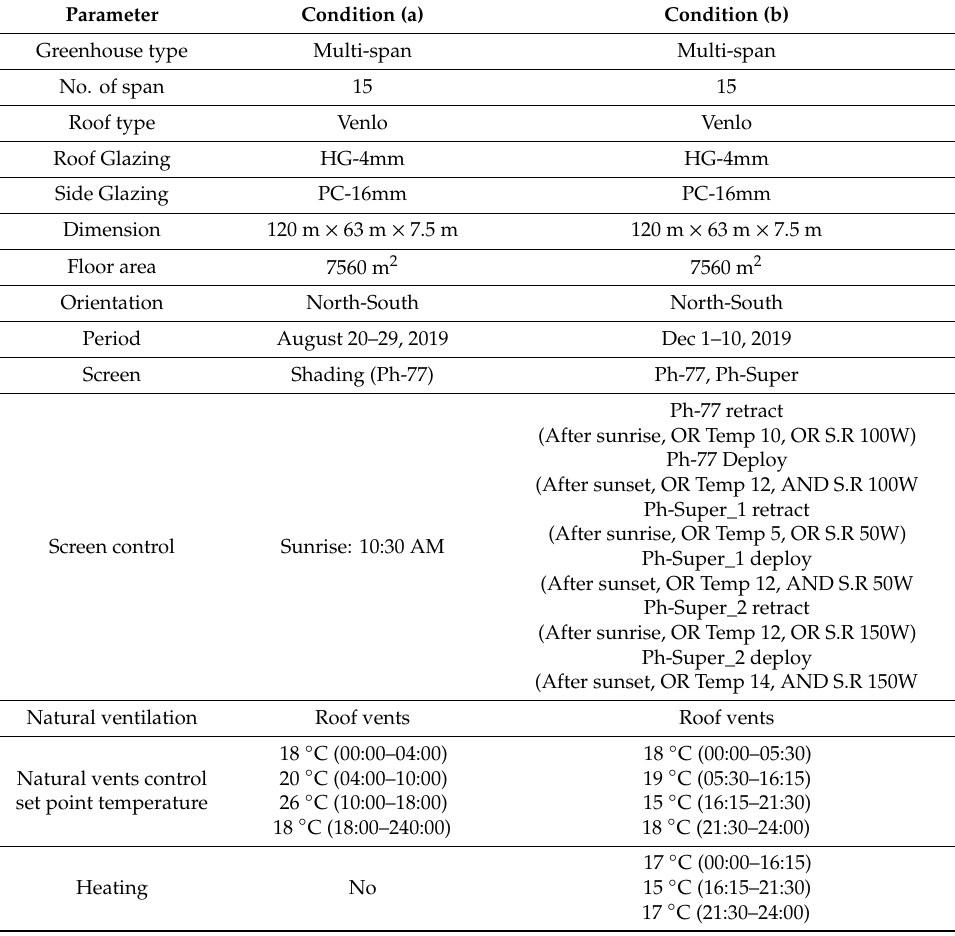
Table 5. Summary of reference